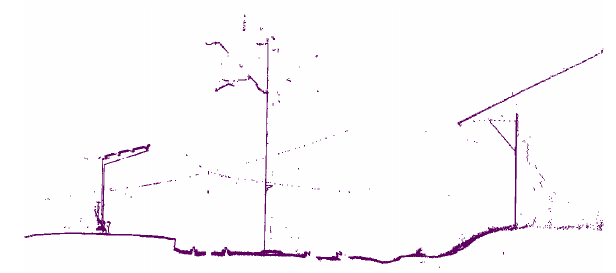
Figure 5. Track reference measurement with the use of the most